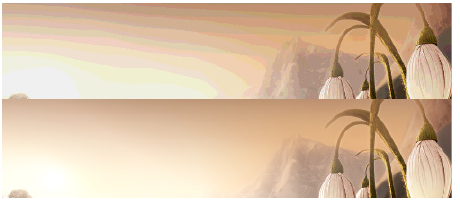
Figure 1. False contour example [37]. The upper part is the reconstructed 16-bit image from 4-bit via ZP and the lower part is the 16-bit